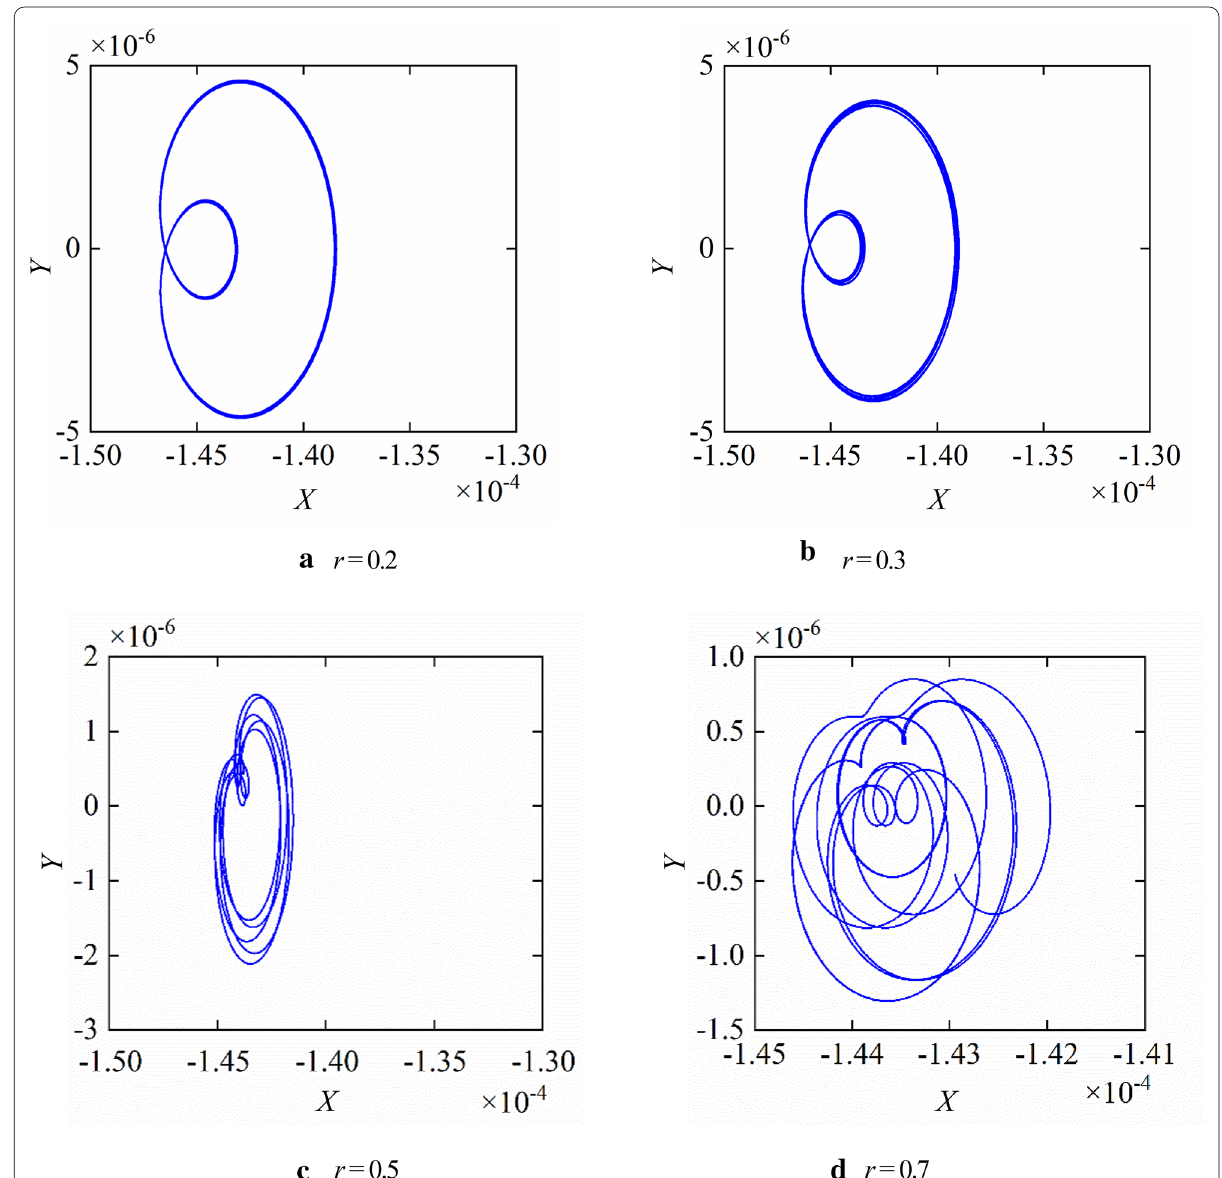
Figure 5 Shaft orbit of rotor system with a slant crack based fractional damping (under the different fractional order)